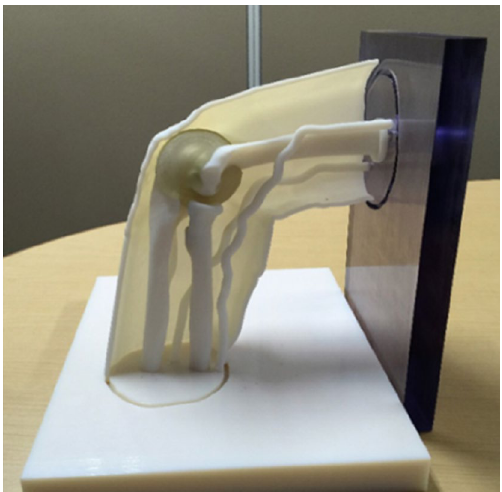
Figure 1. A real size 3-dimensional (3D) model of organs and frame. The model was constructed using a standard triangulated language (STL) 3D printer (Object500 Connex, Stratasys Ltd,